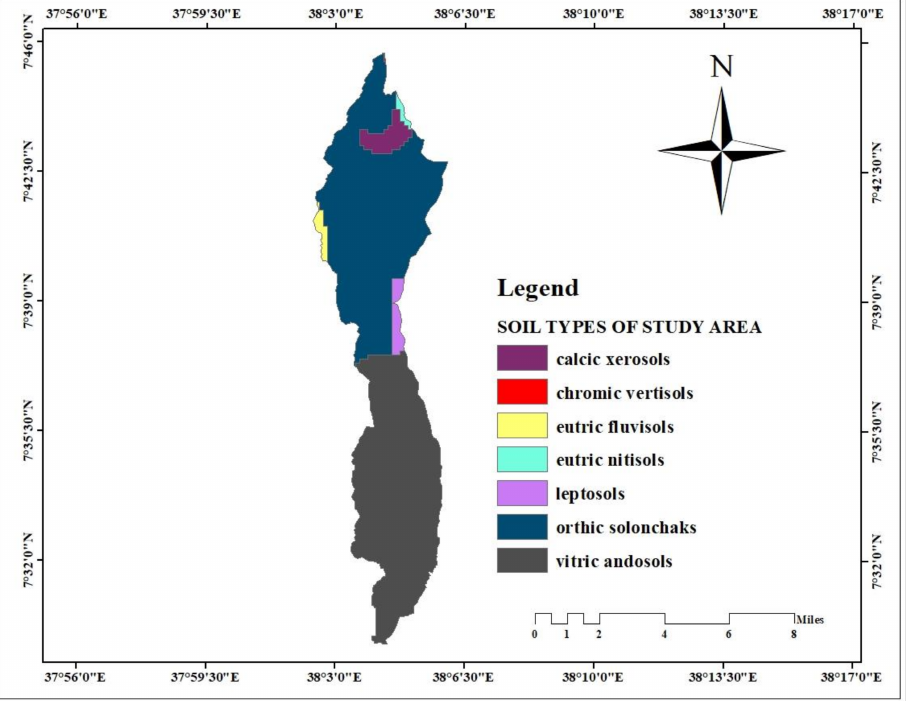
Figure 4. Major soil types map of Matenchose